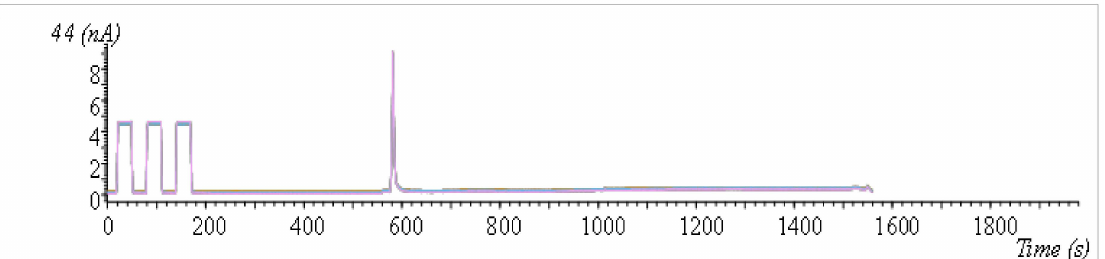
Figure 1. A GC-C-IRMS chromatogram with an ethanol peak at around 590 s. The colors in the figure present the isotopologues of CO 2 , which are m/z 44,45,46.